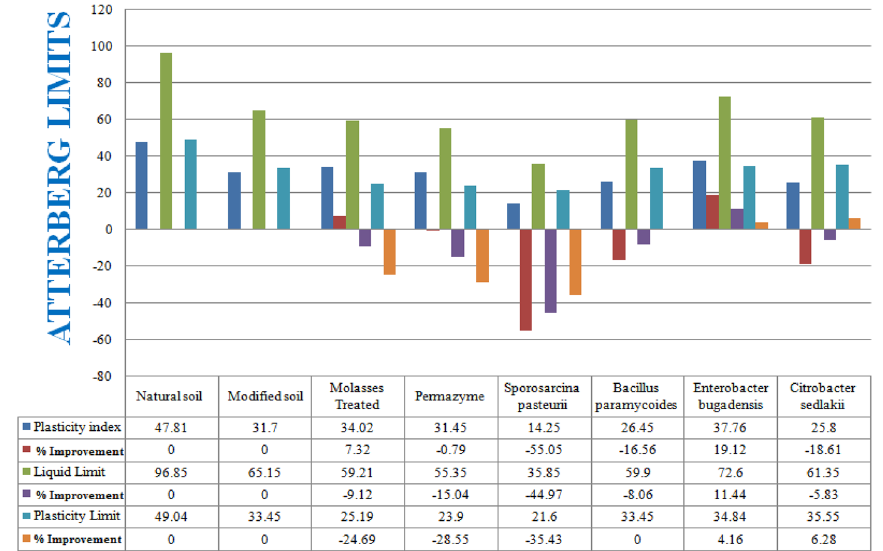
Fig. 2 Atterberg limits of natural, modified, molasses and bioenzyme treated soil